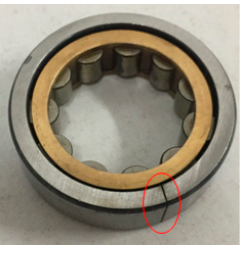
Figure 18. Planetary bearing outer ring fault surface map.